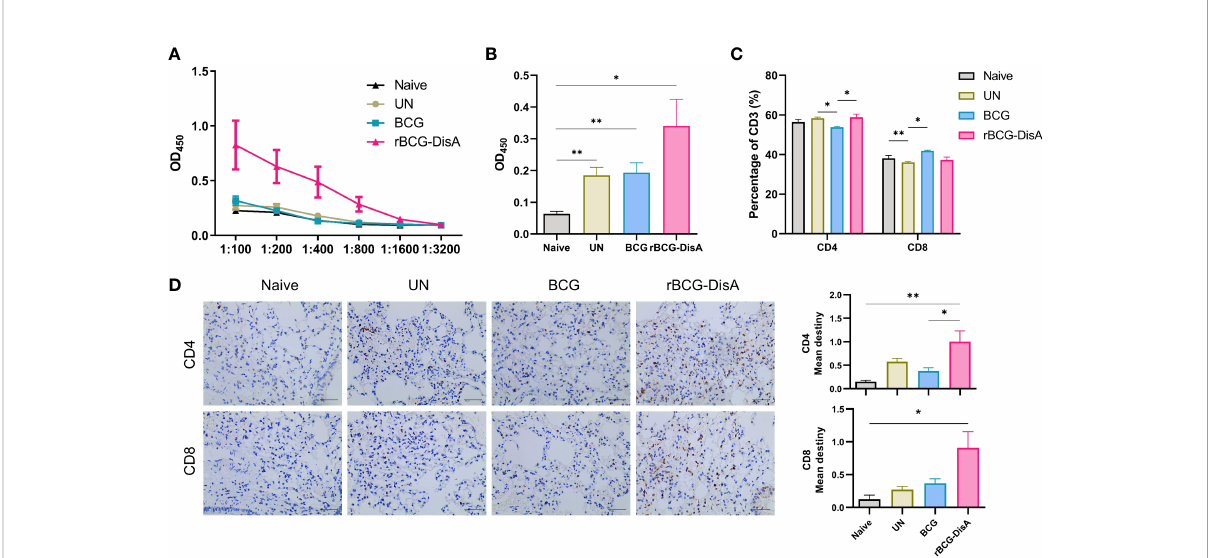
FIGURE 6 Analysis of speci fi c antibodies and T cells in the spleen and lung of vaccinated mice after M. tuberculosis infection. Mice were vaccinated by i.v BCG and rBCG-DisA for 12 weeks. Then, mice were infected with M. tuberculosis by i.n route, normal mice (Naïve) and M. tuberculosis infected mice without immunization (UN) were used as control. (A) At 6 weeks post infection, BCG-speci fi c IgG titers in sera were determined by ELISA at indicated dilutions ( n =4). (B) At 6 weeks post infection, DisA-speci fi c IgG levels in sera was determined by ELISA at dilution of 1:200 ( n =4). (C) At 6 weeks post infection, proportions of CD4 and CD8 T cells in splenocytes were assayed by fl ow cytometry ( n =4). (D) At 6 weeks post infection, immunohistochemical analysis of CD4 and CD8 T cells in the lung of mice (left). Quantitative analysis of CD4 and CD8 T cells by Image J (right) ( n =3). (* P < 0.05, ** P <